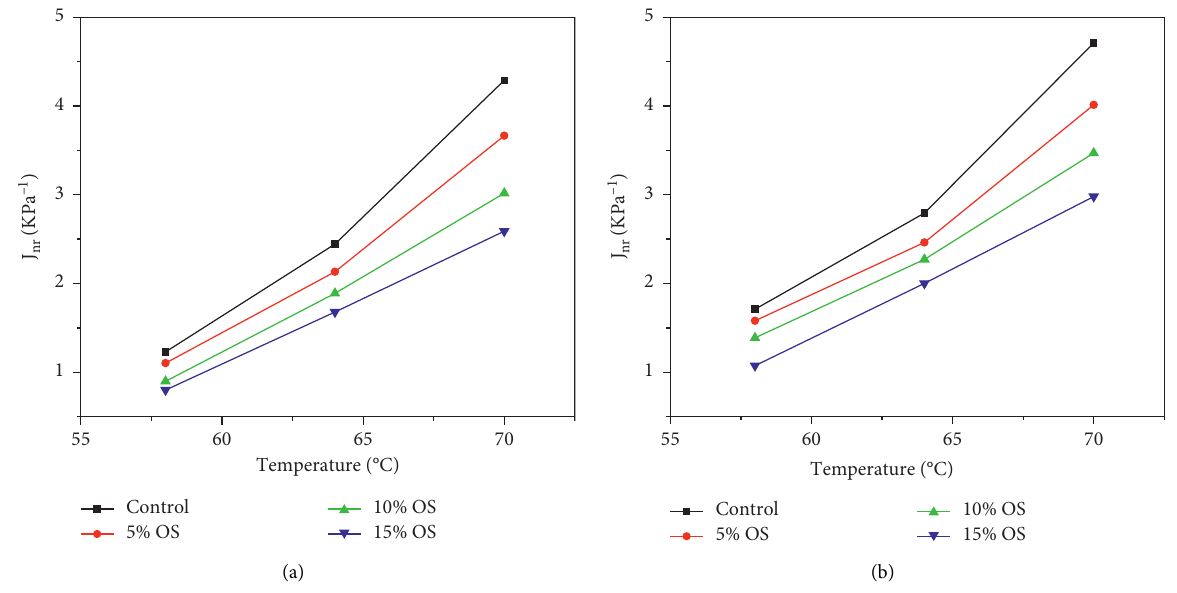
Figure 9: Average irrecoverable creep flexibility of studied materials. (a) 0.1kPa. (b) 3.2 kPa.